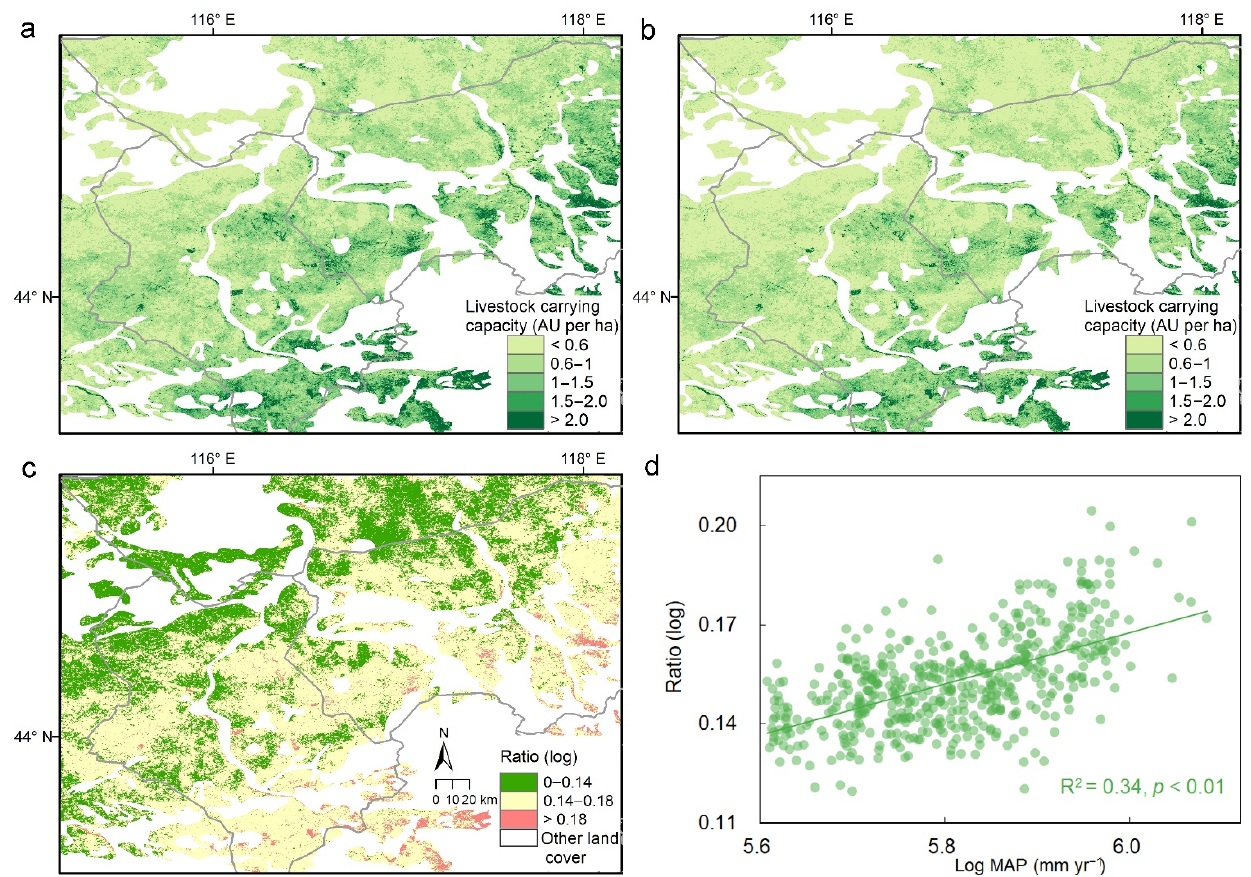
Figure 7. Livestock carrying capacity (AU per ha) estimated using forage biomass ( a ) and crude protein ( b ), the ratio between these two estimates ( c ), and shifts of the ratio with MAP ( d ). AU refers to a national standard sheep with a mass of 50 kg that consumes 1.4 kg of dry matter (forage bio- mass) and 182 g crude protein per day (reference to the national standard NY/T635-2015 and NY/T3647-2020; Ministry of Agriculture and Rural affairs of the People’s Republic of China). ( a , b ) has the same scale as in ( c ).